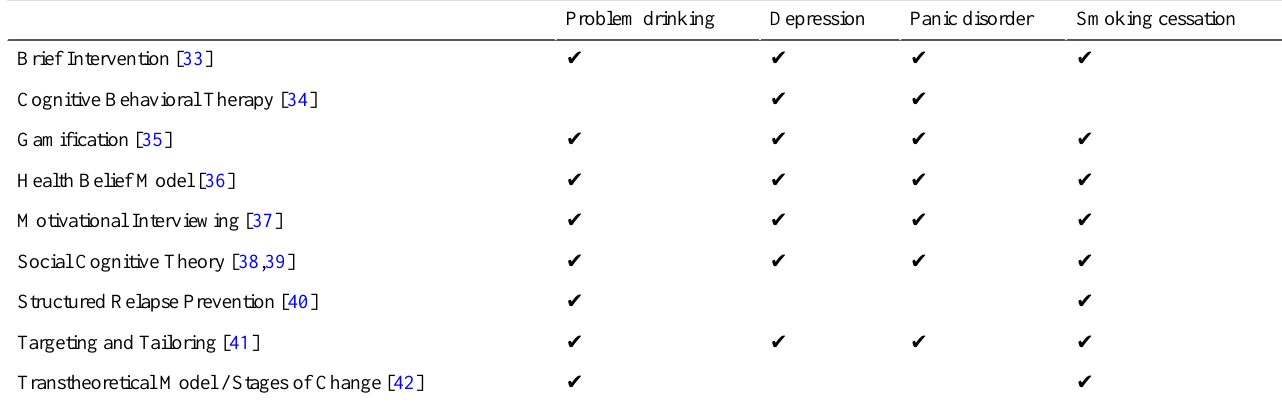
Table 2. Theoretical underpinnings of behavior-change